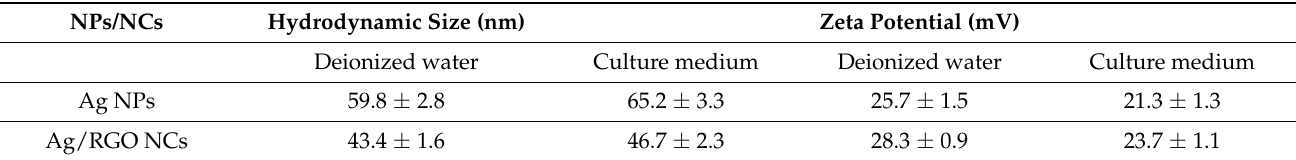
Table 1. Dynamic light scattering (DLS) characterization of Ag NPs and Ag/RGO